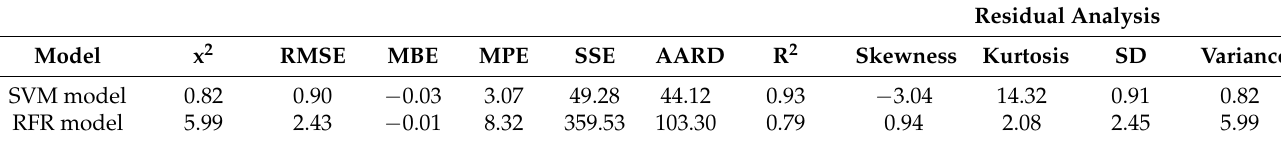
Table 3. “Goodness of fit” for developed SVM and RFR